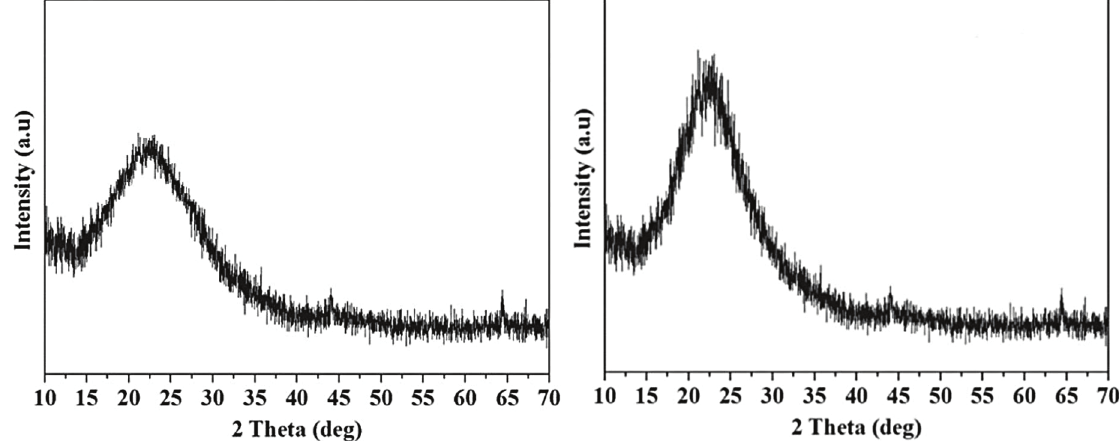
Fig. 3 – X-Ray diffraction of rice husk, left: raw rice husk, right: rice husk